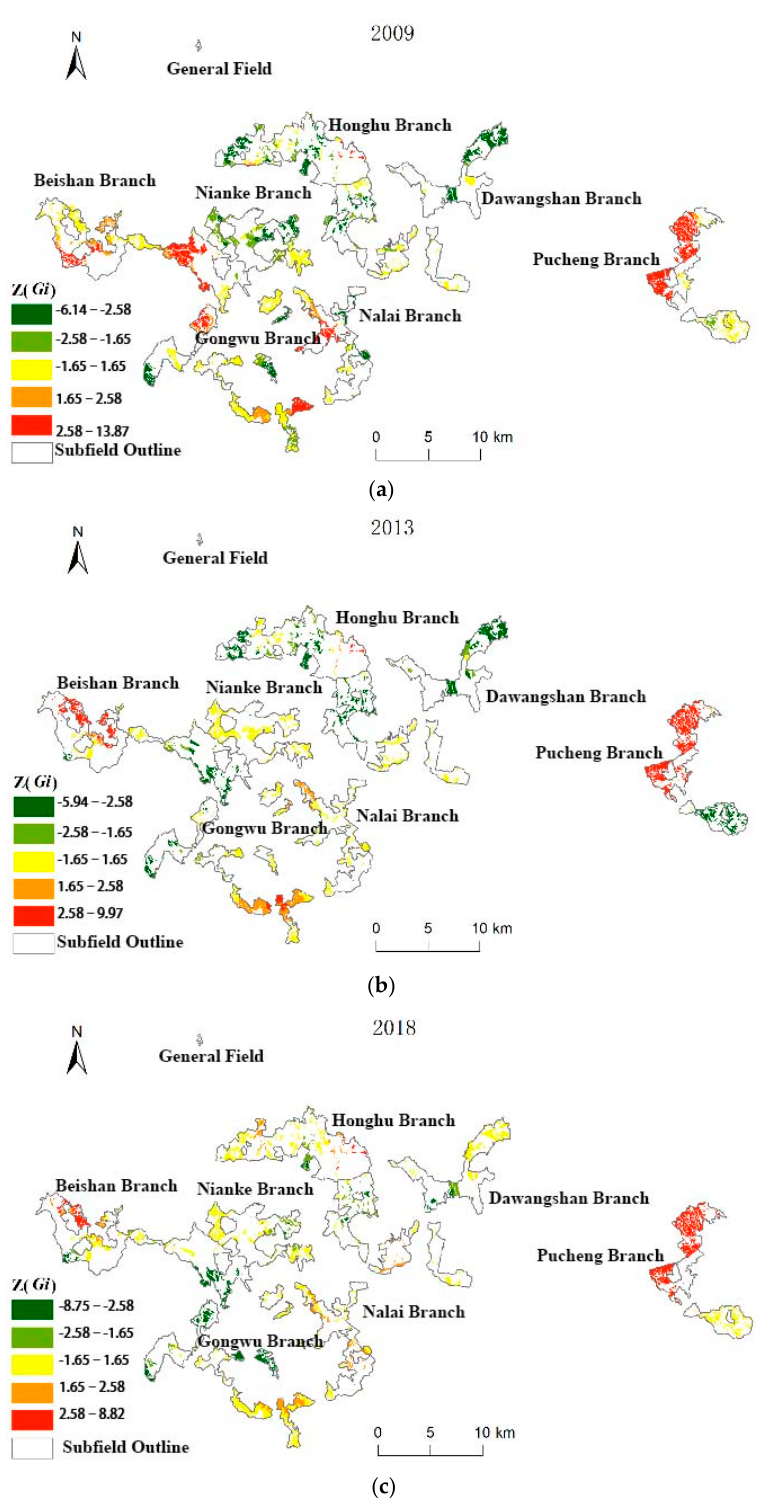
Figure 7. This fi gure shows the distribution of cold–hot spots of wood supply for PM plantations in Paiyangshan Forest Farm from 2009 to 2018, with Z(Gi*) as the aggregation index degree parameter. The color scheme used is red for hot spot regions, orange for sub-hot spot regions, yellow for insigni fi cant regions, dark green for cold spot regions, and light green for sub-cold spot regions. Panel ( a ) displays the distribution of cold–hot spots in 2009, panel ( b ) displays the distribution in 2013, and panel ( c ) displays the distribution in 2018.